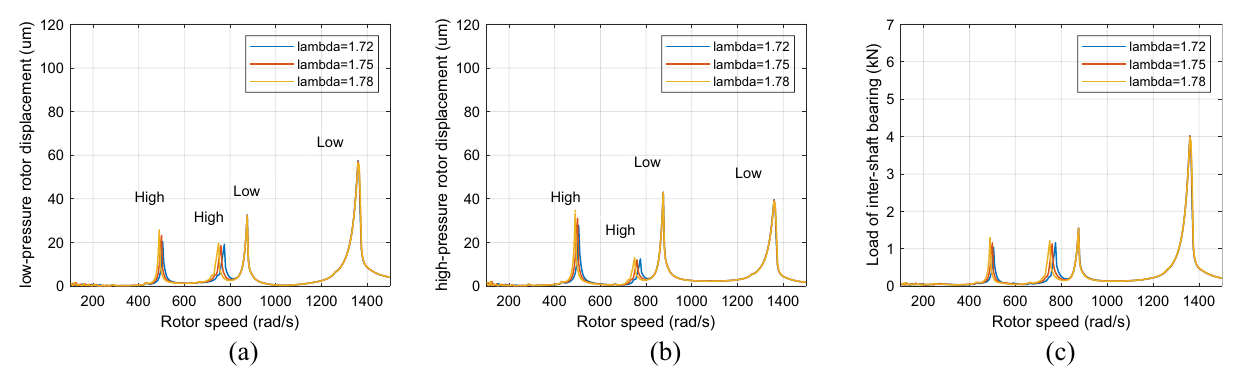
Figure 7. Amplitude-frequency response curve without defect (λ = 1. 72, 1. 75, 1. 78, F 0 = 0, A max = 0) ( a ) LP rotor ( b ) HP rotor ( c ) inter-shaft bearing’s load.